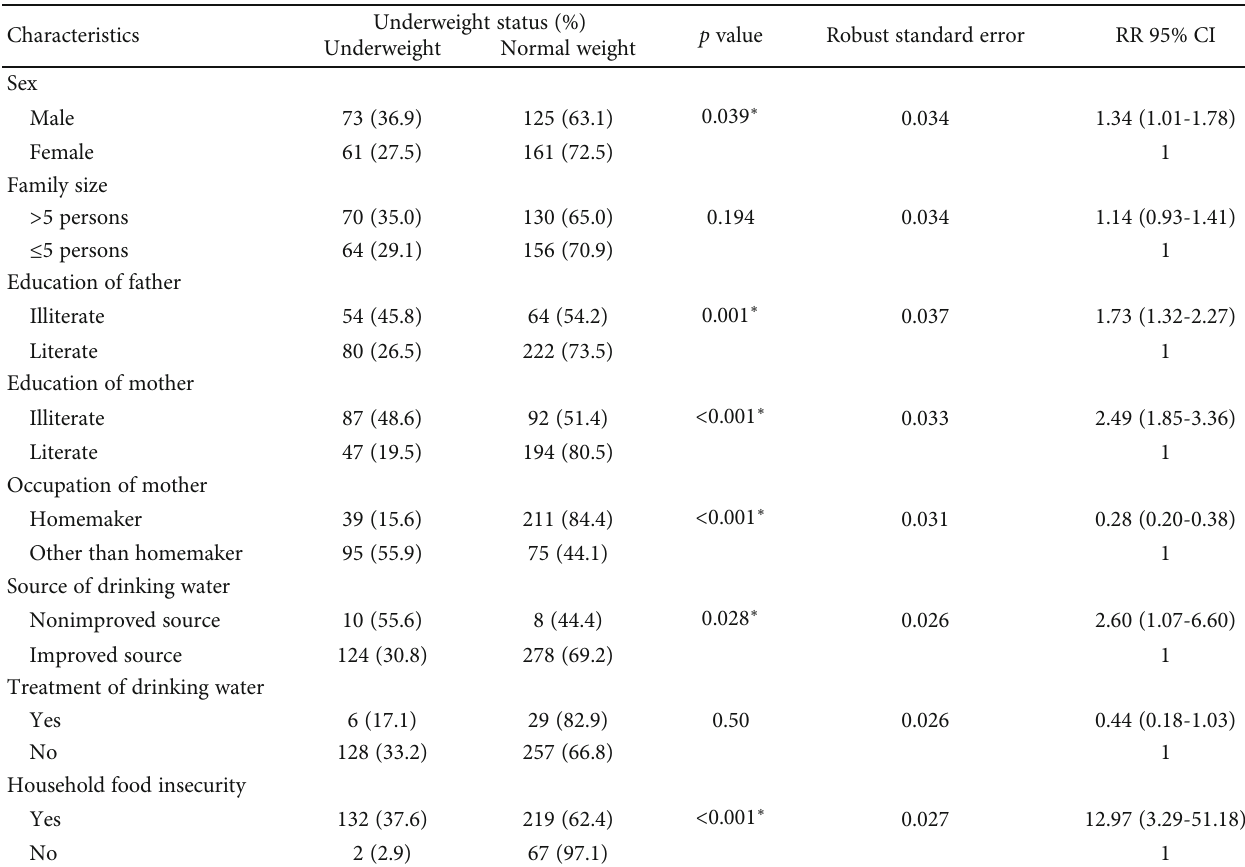
Table 5: Factors associated with underweight in using log-binomial regression